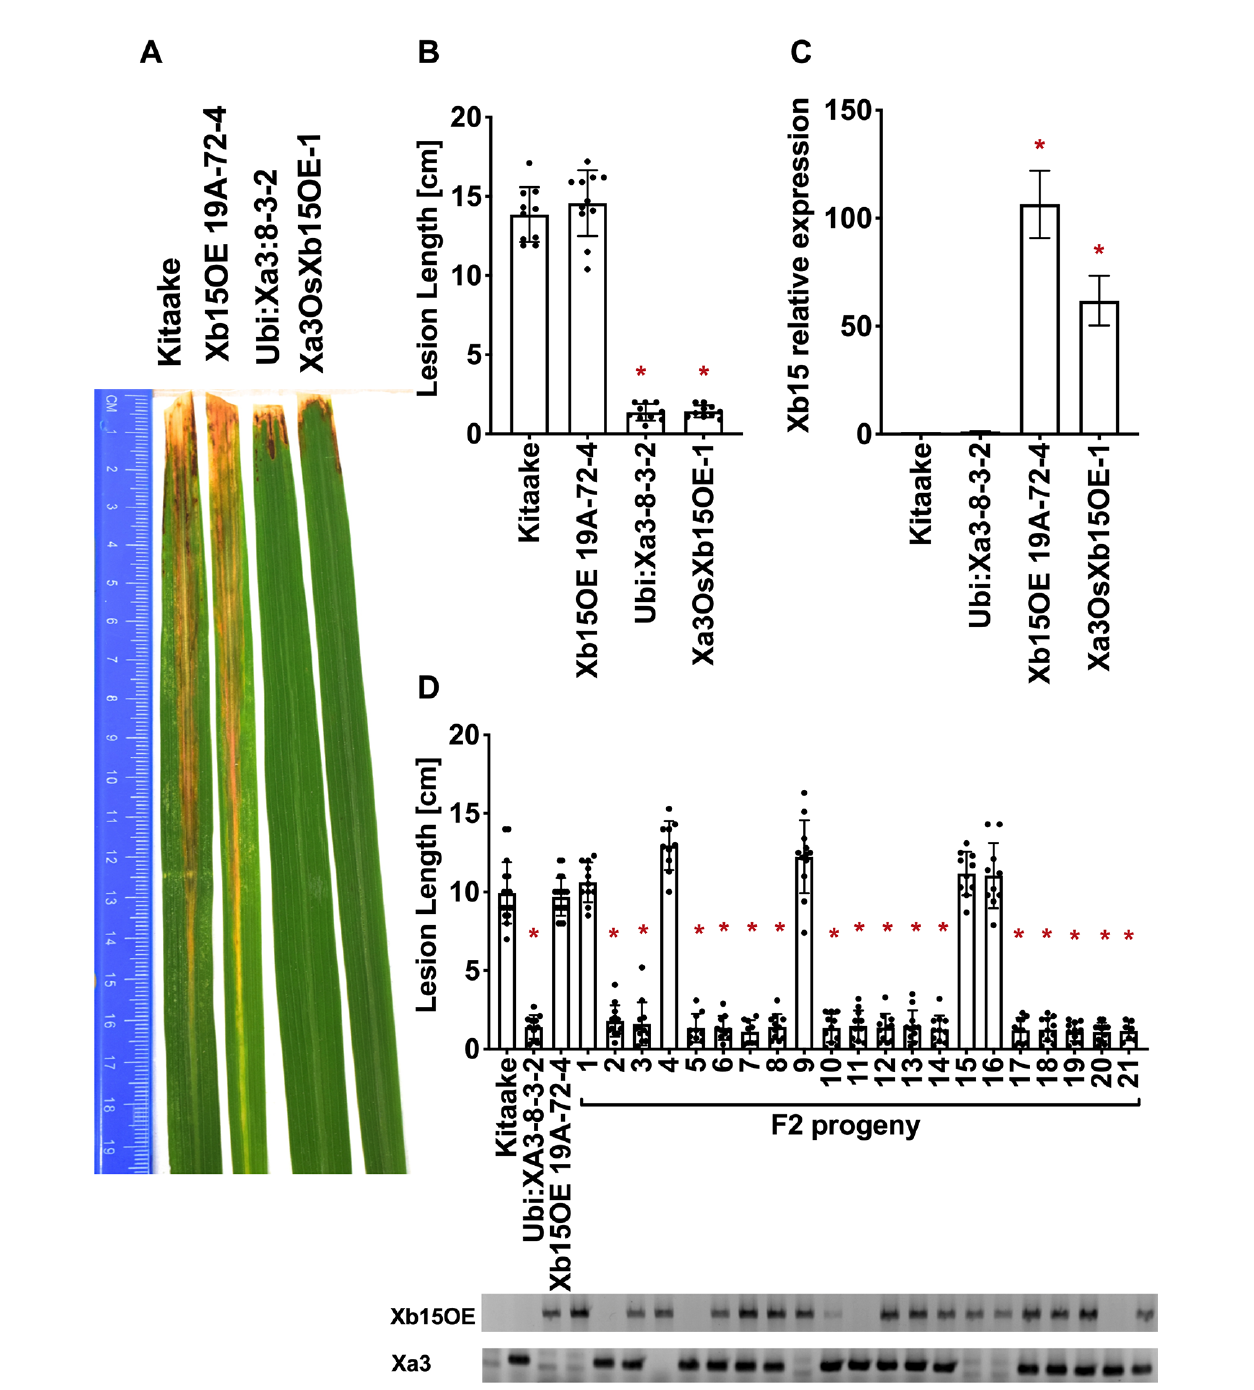
FIGURE 6 | OsXB15 is not required for XA3-mediated immunity in the Kitaake genetic background. (A) Photographed 14 days after inoculation with Xoo strain PXO79. The inoculation method was described in Figure 1 . Control lines used were Kitaake, Ubi : Xa3-8-3-2 and OsXb15OE 19A-72-4 . (B) The average lesion length data of the inoculated leaves (n = 8 – 12). “ * ” indicates a statistically signi fi cant difference from Kitaake using Dunnett's test ( a = 0.05). (C) The qRT-PCR result shows that OsXb15 is highly expressed in the inoculated F1 plant ( Xa3OsXb15OE-1 ). Gene expression measurement is the average of three biological replicates. “ * ” indicates a statistically signi fi cant difference from Kitaake using Dunnett's test ( a = 0.05). (D) The average lesion length data of the inoculated F2 segregating population. Kitaake, Ubi : Xa3-8-3-2 and OsXb15OE 19A-72-4 were used as control lines. Bars represent means of 8 – 12 leaves. “ * ” indicates a statistically signi fi cant difference from Kitaake using Dunnett's test ( a = 0.05). PCR genotyping for the OsXb15OE construct and Xa3 transgene are shown below the bar